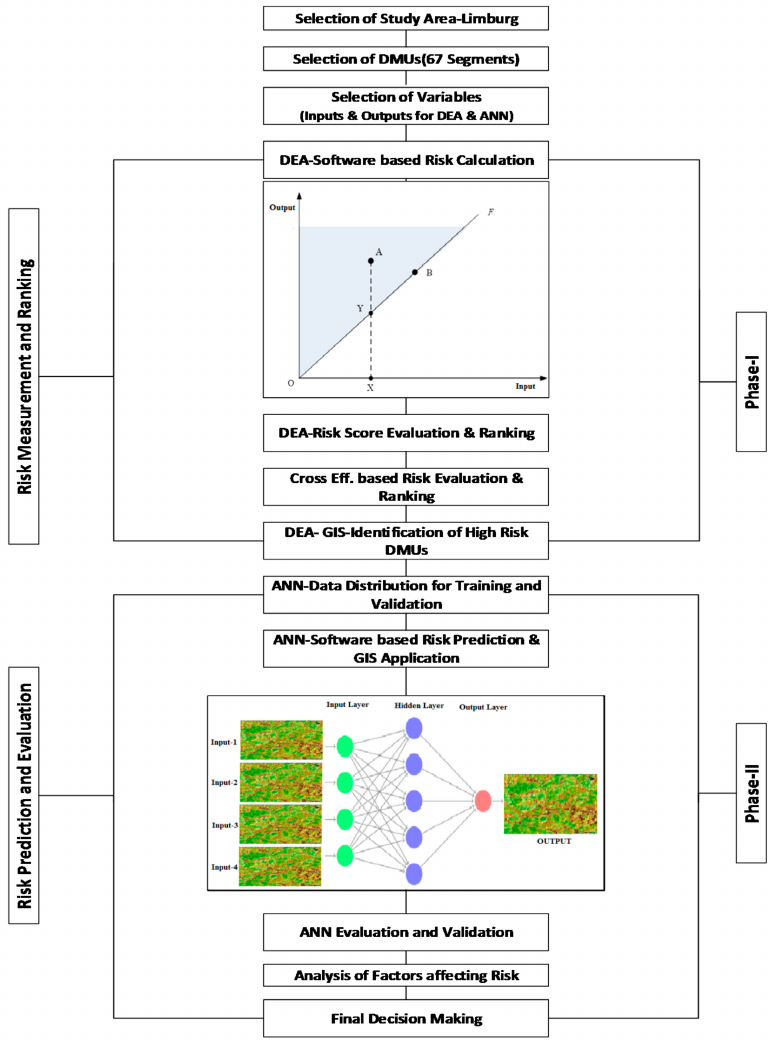
Figure 1. The Proposed Data Envelopment Analysis-Artificial Neural Networks (DEA-ANNs) Framework for Risk